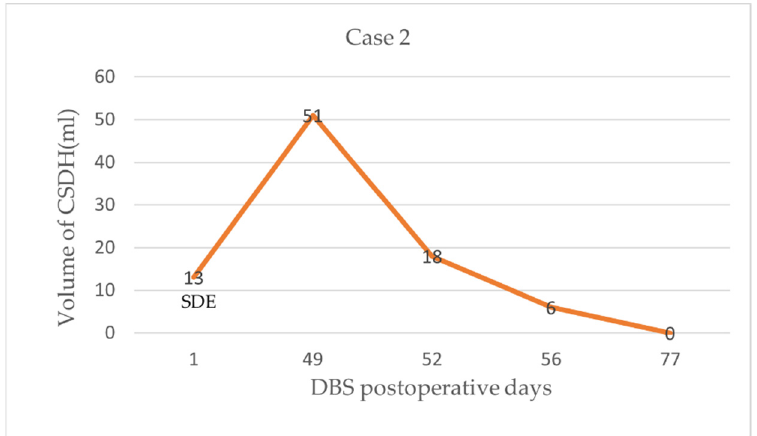
Figure 5. The change in CSDH volume in pre- and post-operative evacuation in case 2. At 1 day after DBS surgery, CT shows the volume of subdural effusion (SDE) in the left frontal lobe was 13 mL; at 49 days after DBS surgery, the volume of right chronic subdural hematoma is 51 mL; at 3 days after drainage, residual hematomas volume was 18 mL; until day77, the hematoma was completely absorbed.